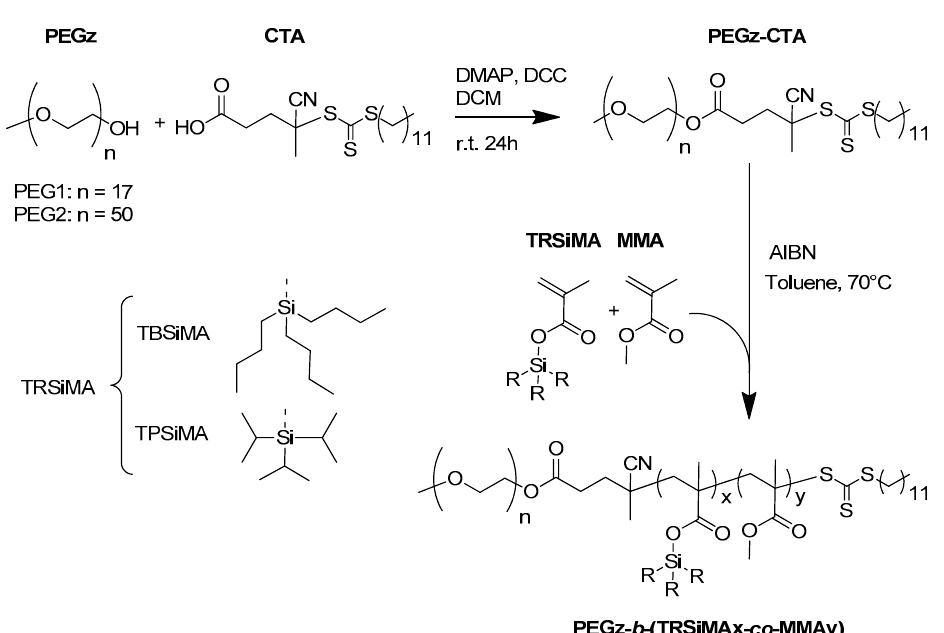
Figure 1. Synthesis of amphiphilic hydrolyzable diblock copolymers via RAFT copolymerization of TRSiMA (R = isopropyl, butyl) and MMA with PEGz-CTA.